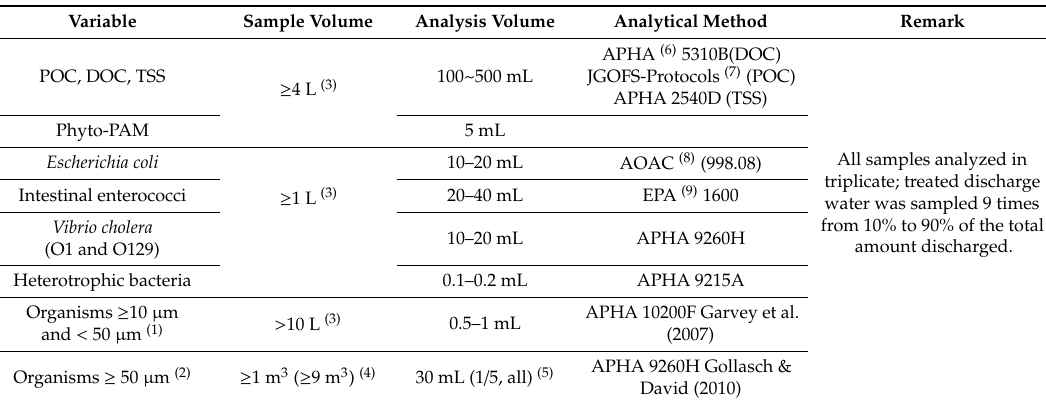
Table 3. Sampling, analysis volumes, and analysis